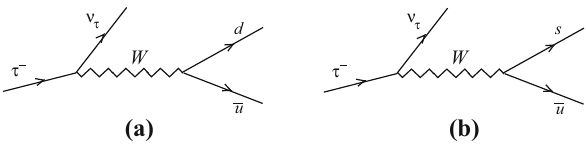
Fig. 1 a Cabibbo favored τ − decay to quark-antiquark. b Cabibbo suppressed decay